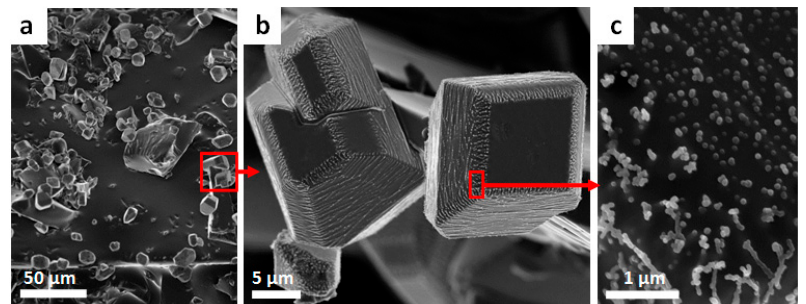
Polymers 2017 , 9 , 59 6 of 16